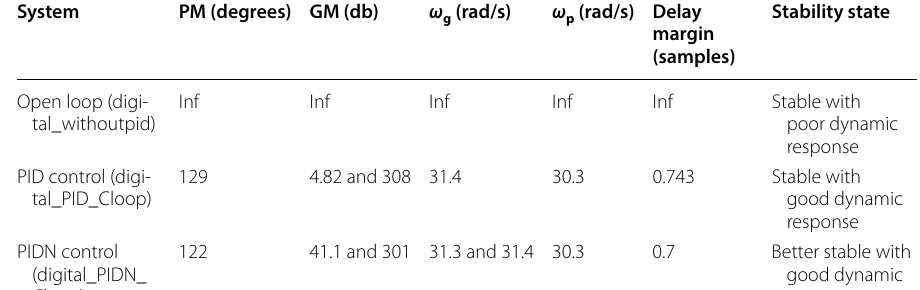
Table 7 Comparison of stability analysis in digital domain of BBC in buck mode of operation System